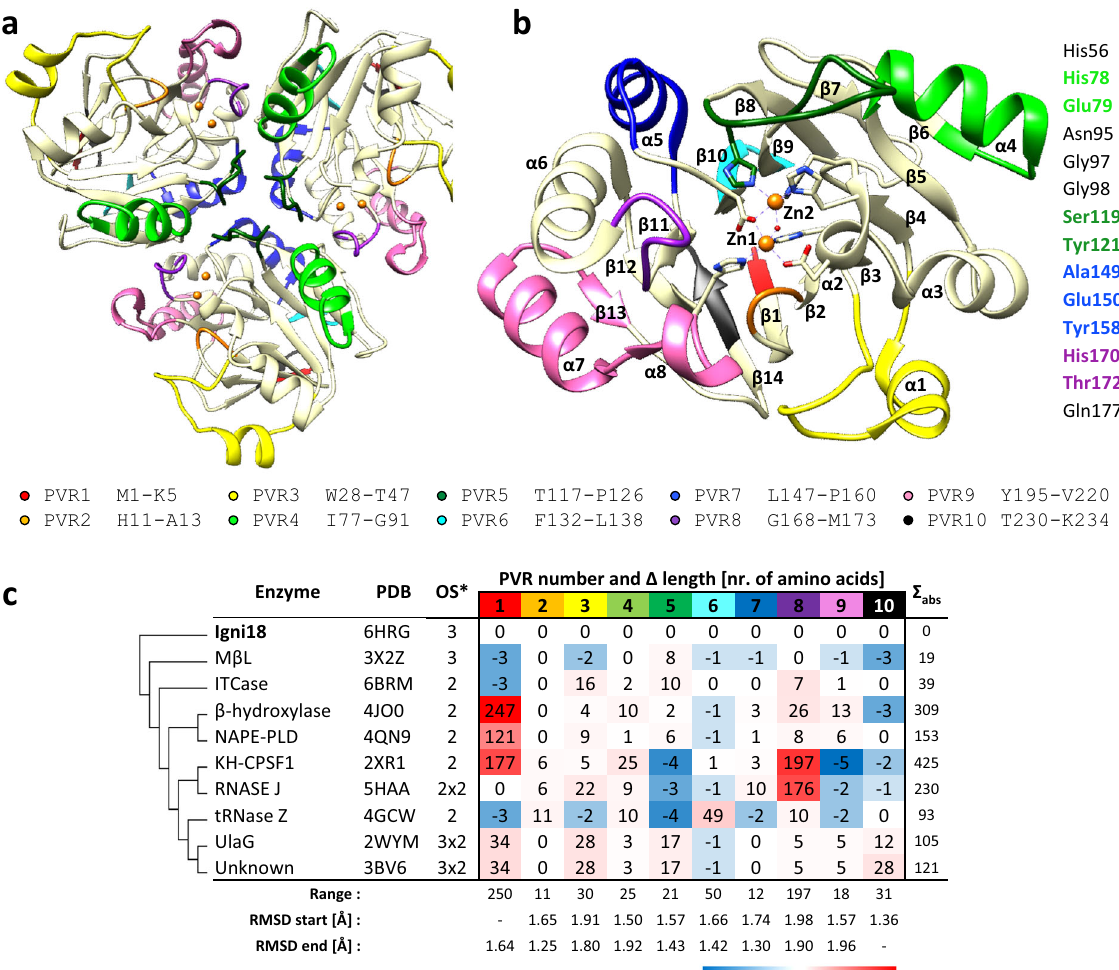
Fig. 1 The crystal structure of Igni18 reveals the origin of diverse M β Ls. The protein crystalized as a homotrimer ( a ). A monomer ( b ) comprises 8 α - helixes and 14 β -strands and contains two Zn 2 + ions (orange). Ten Protein Variable Regions (PVRs) describe structural evolution and specialization within the M β L family and are depicted in a and b . The amino acids comprising each PVR are indicated underneath. In total, 9 out of 14 amino acids needed for stabilization of the trimer are found within PVRs 4, 5, 7, and 8 (light-green, dark-green, blue, and purple; right), leading to an evolutionary fast loss of this quaternary structure. Differences in the number of amino acids of the described PVRs among 10 M β L-fold-containing structures ( c ); Molecular relation (left) and absolute variation in the number of amino acids ( Σ abs , right) compared to Igni18 as well as statistic data on PVR descriptors (total length range> 10 amino acids, start/end position RMSDs for all aligned structures <2 Å; bottom) are also given. Asterisk represents Oligomerization state of the crystallized enzyme (3: trimer; 2: dimer; 2 × 2: double dimer; 3 × 2: triple